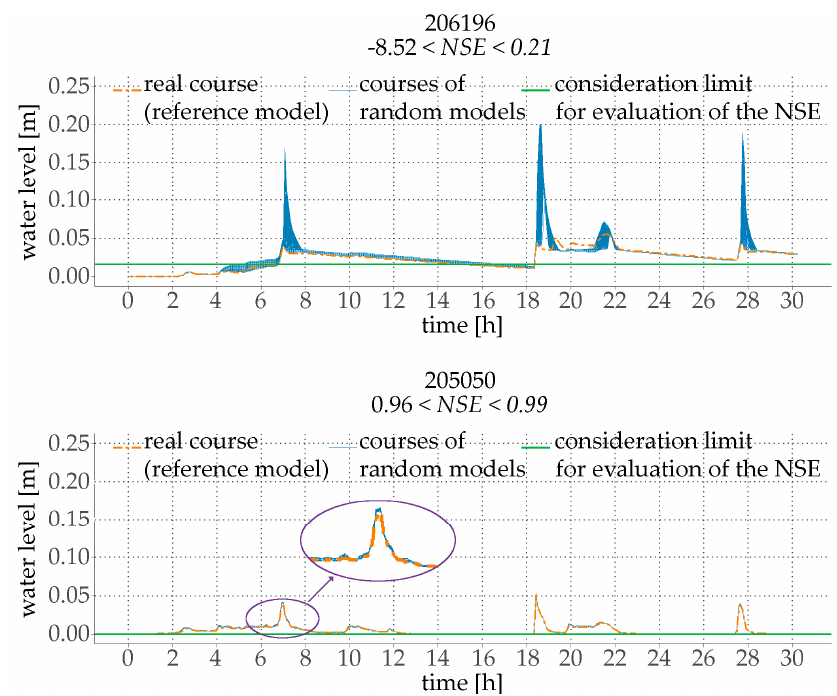
Figure 10. Water level time series of the reference model compared to random models for pipes with the highest ( upper graph ) and lowest ( lower graph ; with a detailed view on the first peak) occurring variation of the NSE.